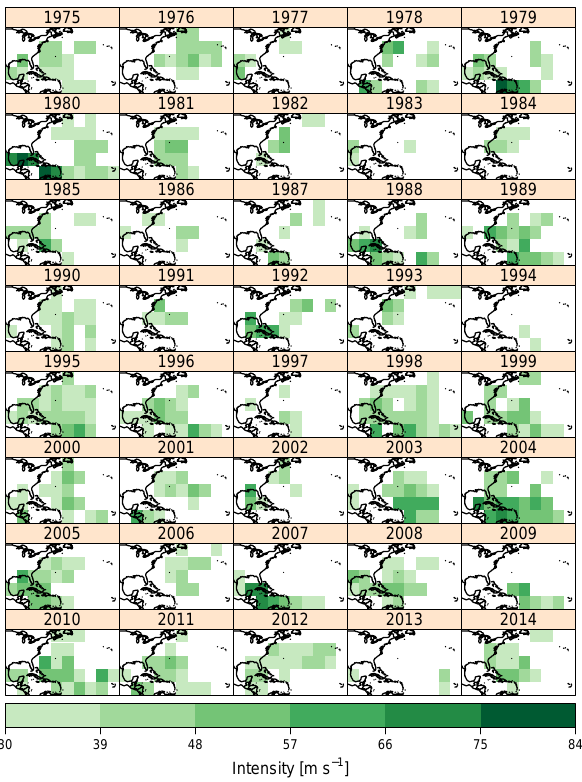
Figure 5. Yearly mean intensity for intensifying hurricanes. Mean intensity is calculated over the period June–October for each year